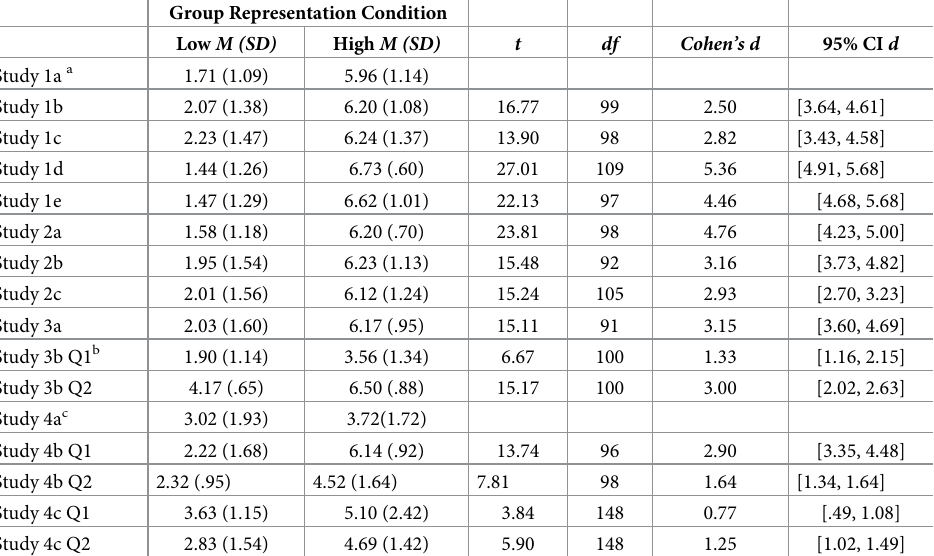
Table 1. Manipulation-check tests for differences between conditions for all relevant